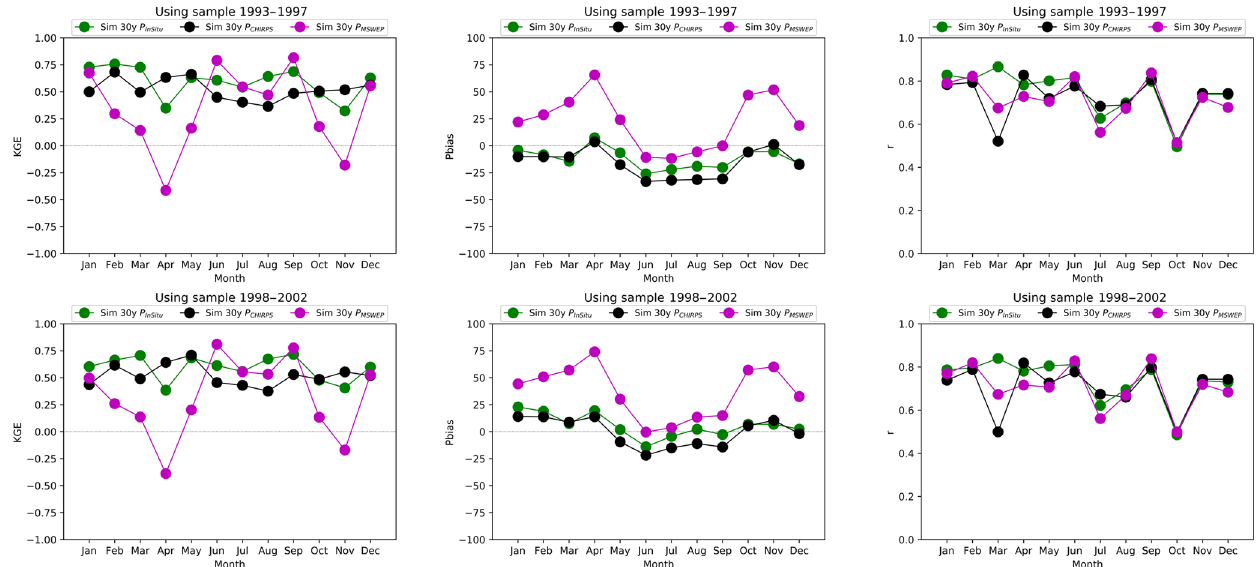
Figure 6. KGE, P bias and r performance metric for simulated river discharge for the complete time period of 30 years (1983–2012) using three different precipitation datasets (in situ, CHIRPS and MSWEP) in the Coello basin. Two calibration samples are shown (1993–1997, 1998–2002), with the sample used to calibrate the model indicated in the header. Table 2. Irrigation areas obtained using different datasets of river discharge information in the Coello basin. The observed river discharge from the complete period of record of 30 years (1983–2012) is the reference information. The irrigation areas are obtained for an agreed water supply reliability of 75% in any one